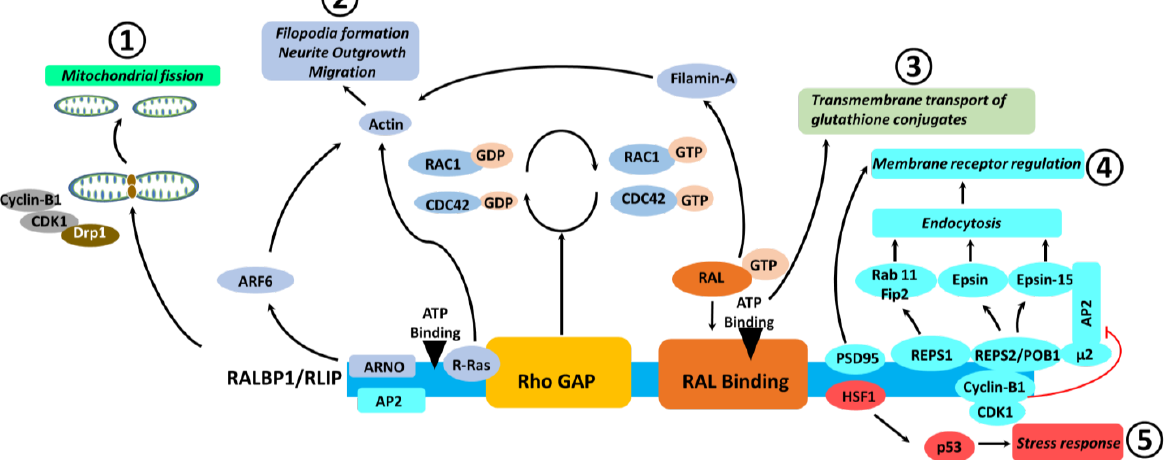
Figure 1. Structure, interactions, and functions of Rlip. Rlip is a 76 kDa multi-domain protein which carries out or regulates a variety of functions. The major resulting endpoints of Rlip activity are enumerated and illustrated as separate pathways. These include ( 1 ) mitochondrial fission, ( 2 ) membrane remodeling activities, ( 3 ) efflux of glutathione conjugates, ( 4 ) receptor regulation via endocytosis, and ( 5 ) stress response.